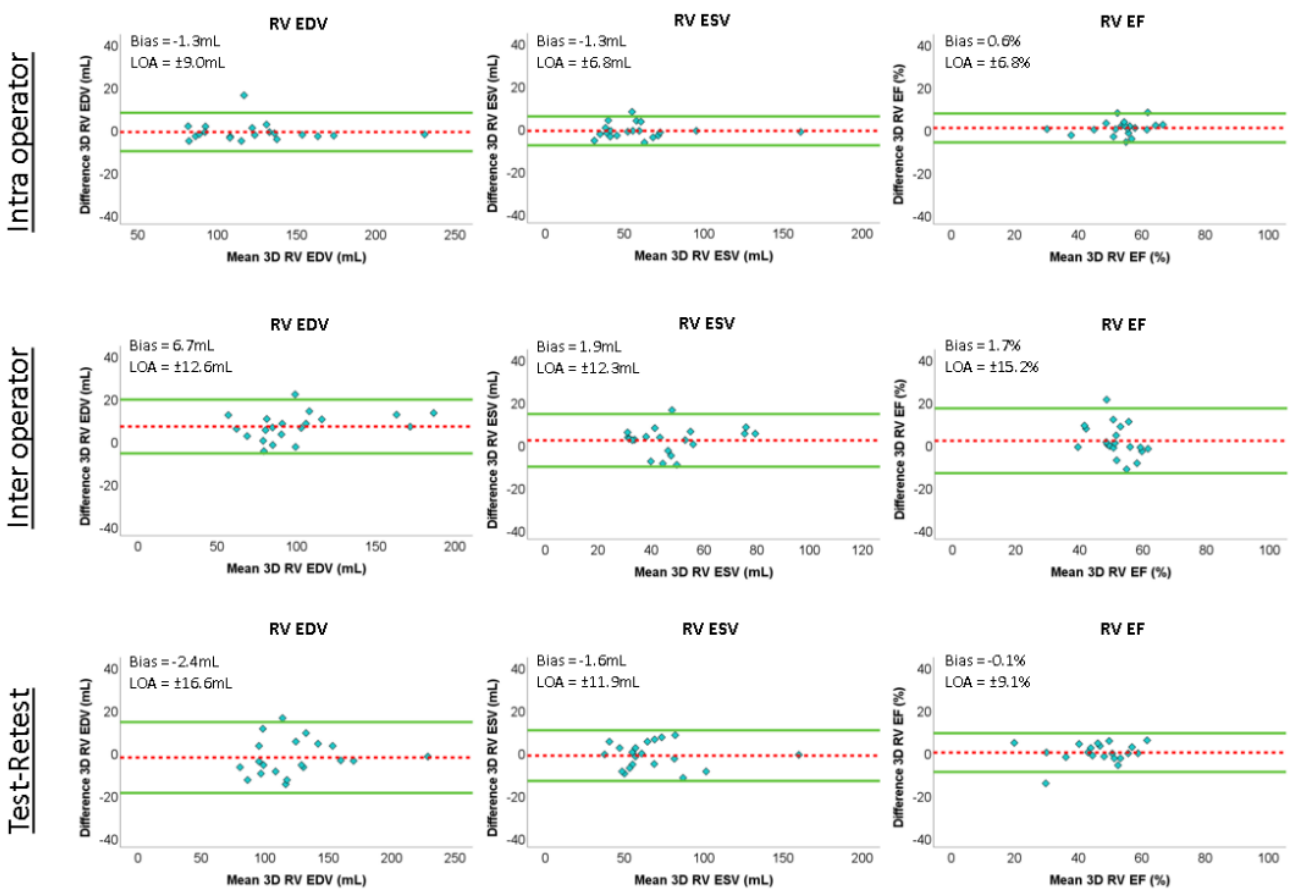
Figure 3. Results of Bland–Altman analysis of the agreement between repeated measurements of right ventricular end–diastolic volume (RV EDV), right ventricular end–systolic volume (RV ESV) and right ventricular ejection fraction (RV EF) for intra–operator (top), inter–operator (middle) and test–retest (bottom) comparisons. Dashed line = bias; soldi line = ± 2 standard deviations; LOA: limits of agreement. Figure 4 andFigure 5 show examples of three cases in whom automated AI-based system where applied. Specifically, an atrial septal defect, a volume overload and a pressure overload patient were